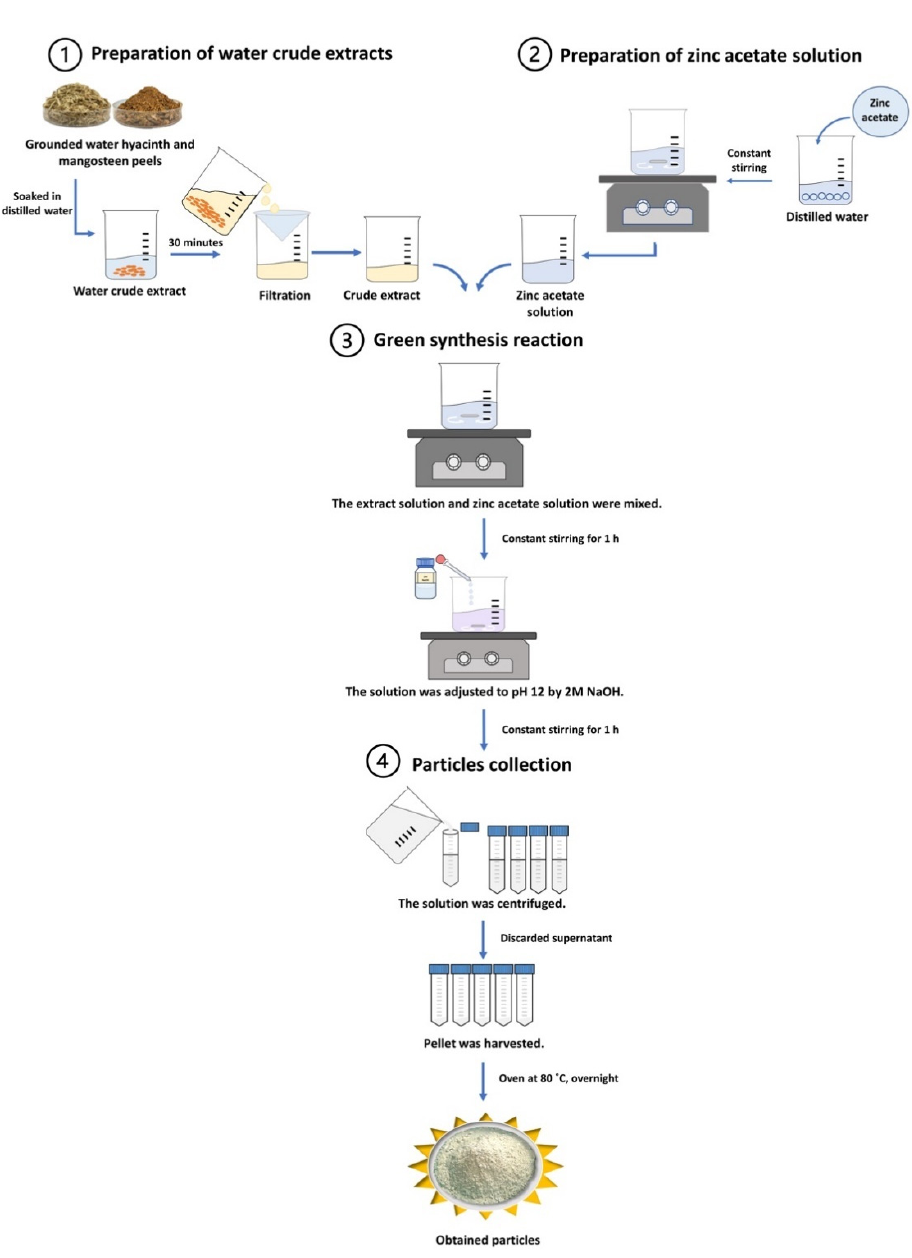
Figure 1. Schematic illustration of green synthesis using mangosteen peels and water hyacinth. For the synthesis of ZnO NPs using mangosteen peel extract, the color of crude extract appeared in pale yellow. The reaction mixture of zinc acetate and the crude extract was purple-blueish in appearance. After pH adjustment, the precipitant was observed to be white in color, implying the formation of ZnO NPs. Likewise, the zinc acetate and crude extract reaction mixture was white in color after pH correction, despite the pale green color of the water hyacinth crude extract. The precipitant was also white, suggesting the presence of ZnO NPs (data not shown).